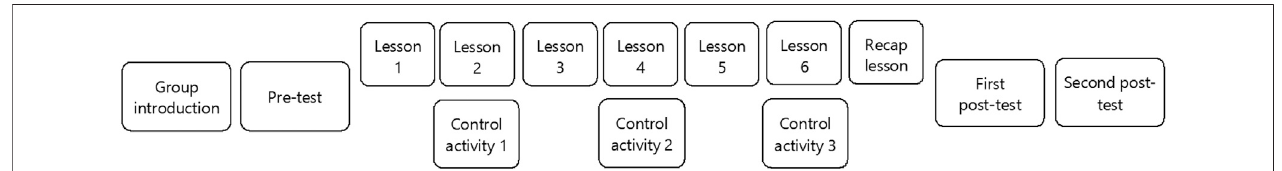
FIGURE 1 | Overview of the experiment.